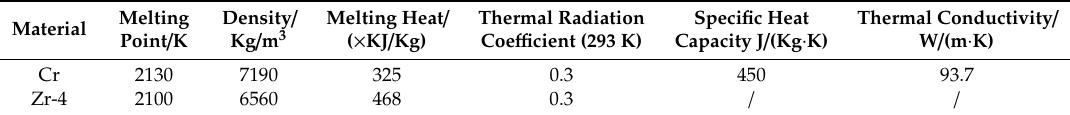
Table 2. Thermophysical properties of Cr and Zr-4 alloy [30].